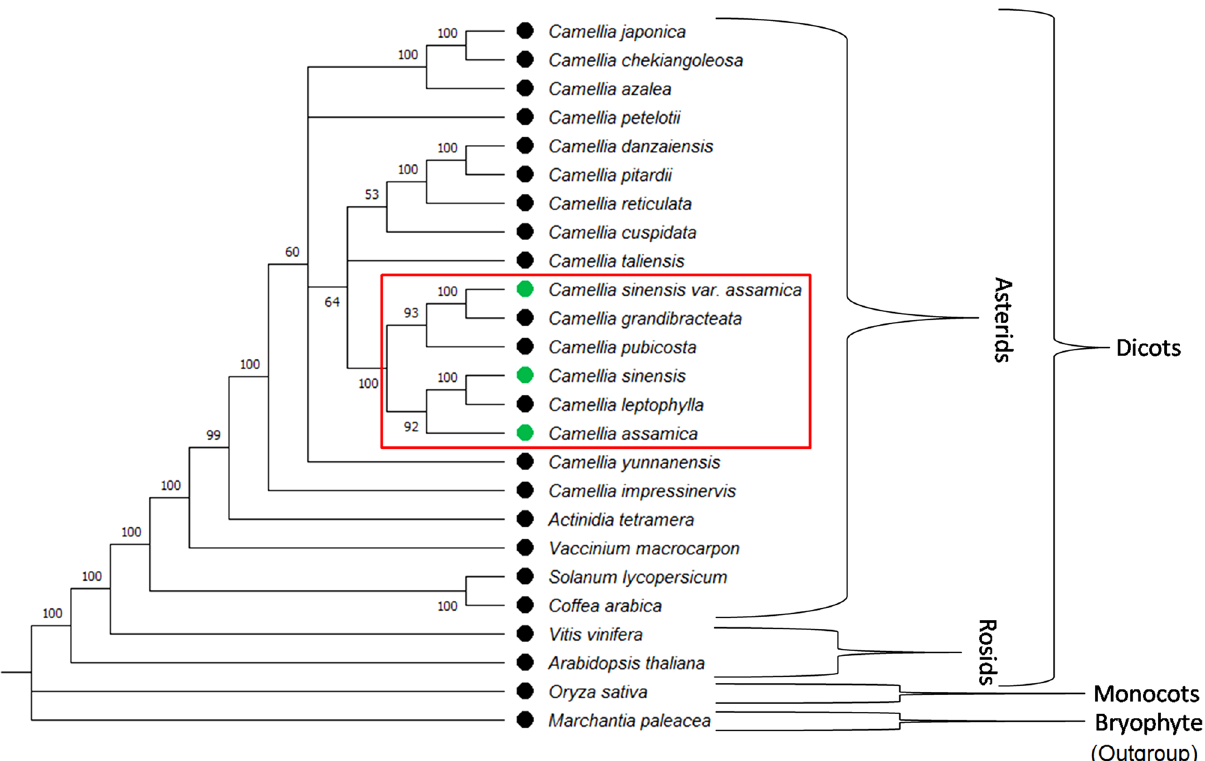
Figure 1. Chloroplast (cp) genome sequence based ML tree showing the phylogenetic relation between China tea, China Assam tea and Indian Assam tea (green bullet) to confirm their different